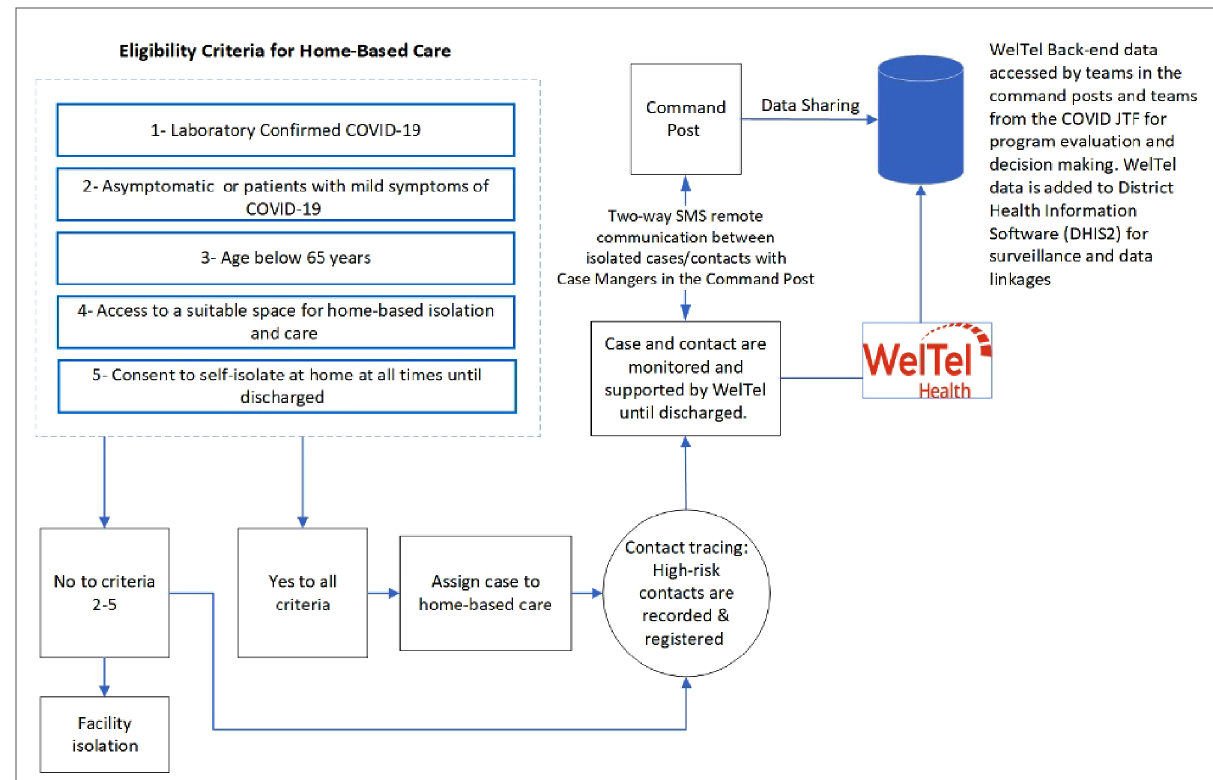
FIGURE 2 Algorithm for Eligibility to Participate in Home-Based Care: Cases and contacts who meet the eligibility for Home-Based Care will be assigned to WelTel for remote monitoring and